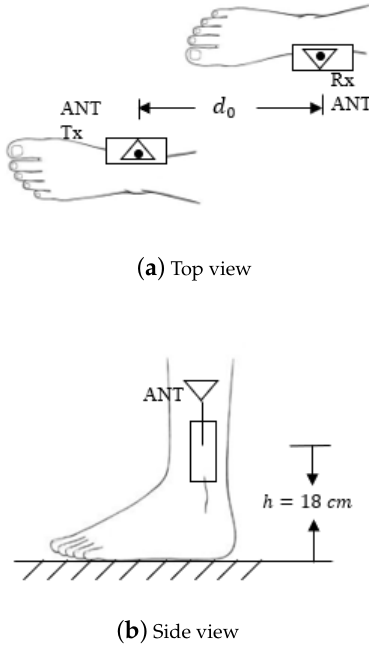
Figure 3. Transceivers attached to the ankles.